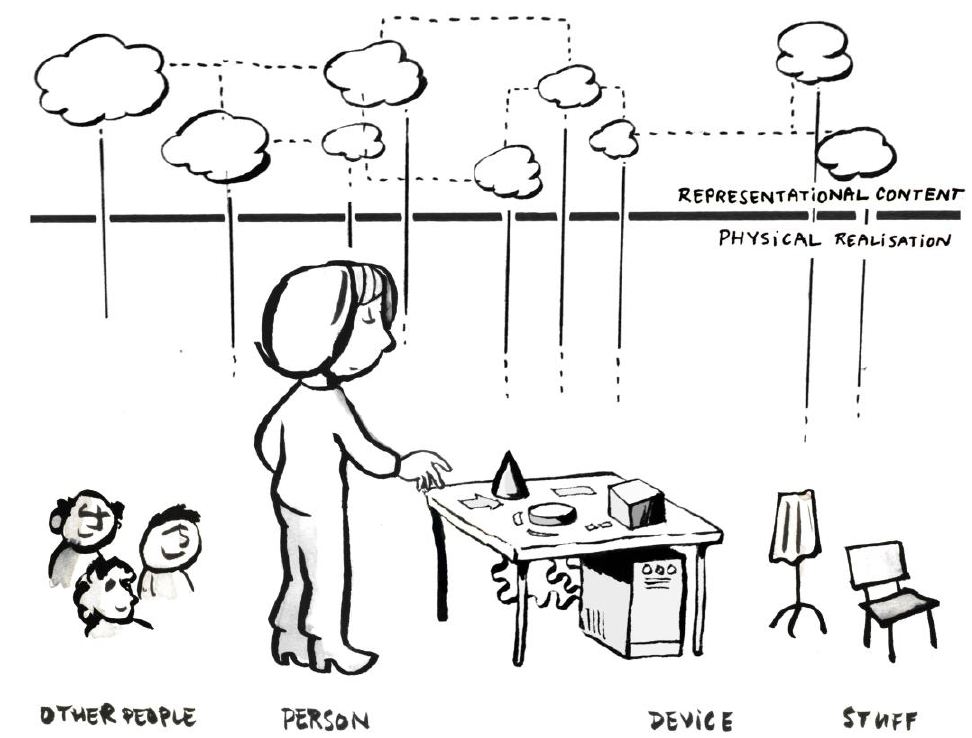
Figure 4. Distributed representation version of Figure 2. The boundary between ‘inner’ mind and ‘outer world’ has dissolved: user and external representations form one distributed system. However, the conceptual distinction between the representational level and its physical realization remains. © Jelle van Dijk.